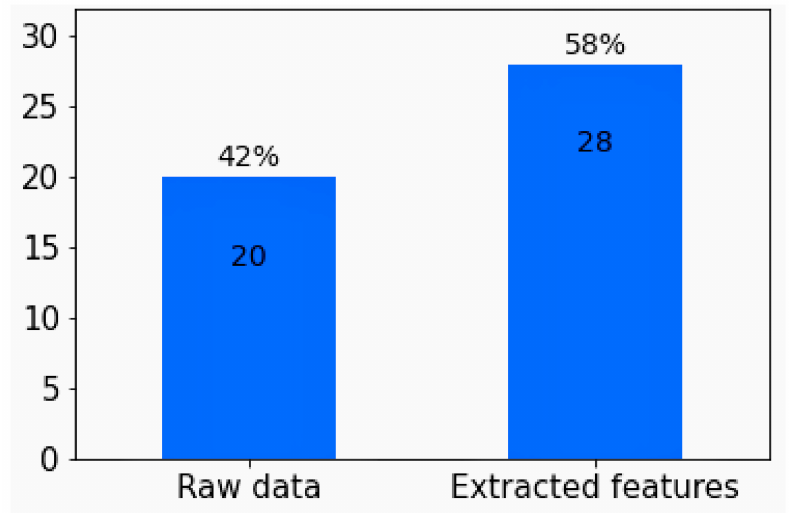
Figure 13. Breakdown of the types of input data.